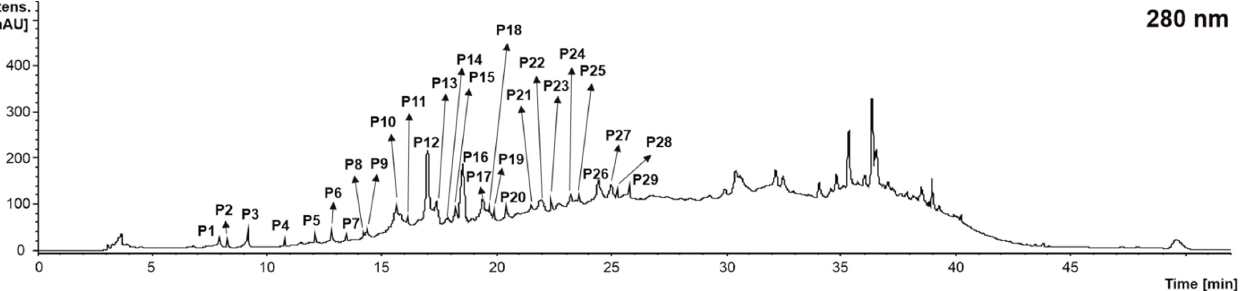
Figure 2. Chromatogram recorded at 280 nm representative of the catechin derivatives and proanthocyanidins (P) recorded in grape stems, grape pomace, and wine lees. Identification of the peaks annotated according to Table 1. Identified catechin derivatives and proanthocyanidins in grape ( Vitis vinifera L. var. ‘Monastrell’) stem, pomace, and wine lees by HPLC-PDA-ESI-MSn operating in negative mode. Peak Compound